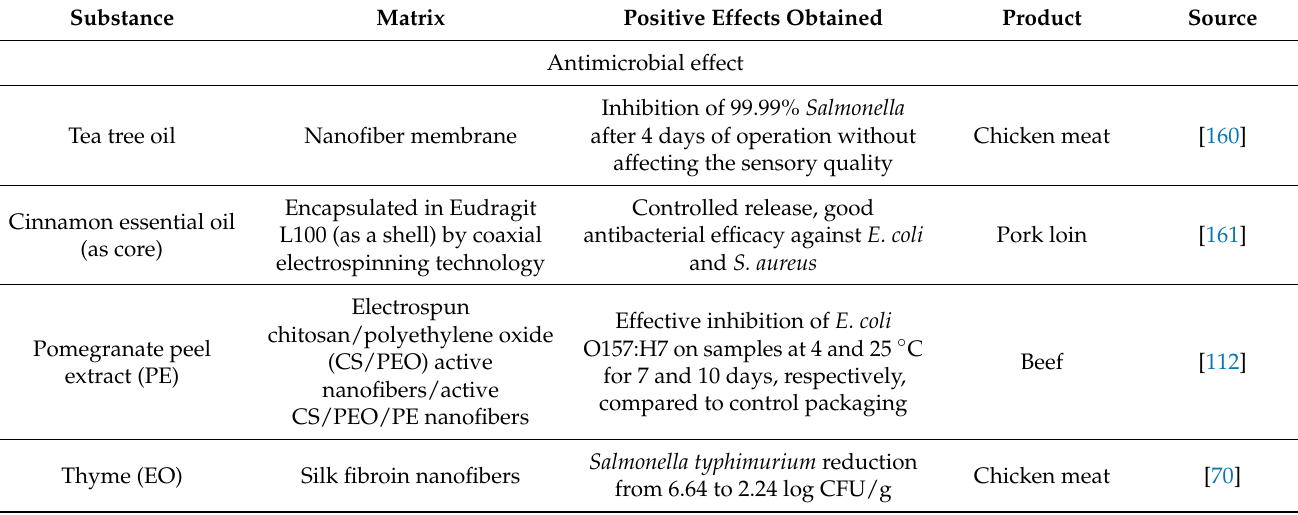
Table 1. Examples and effects of using bioactive substances in packaging